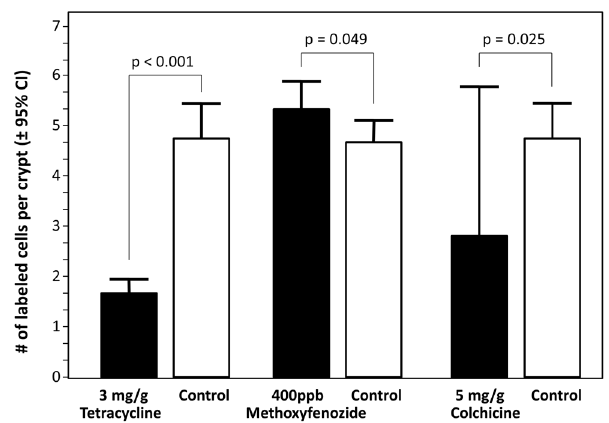
Figure 3. In the first experiment, 3 of the 12 xenobiotics tested had significant effects on the number of labeled nuclei per active crypt. While colchicine and tetracycline decreased the proliferation of ISCs, methoxyfenozide increased activity. Means are shown with 95% confidence intervals.